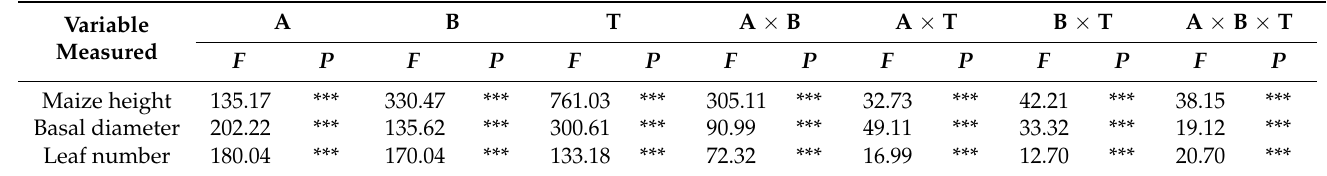
Table 5. Probabilities of significance calculated using a three-way ANOVA for the main treatment effects and treatment interactions of maize height, basal diameter, and leaf number.